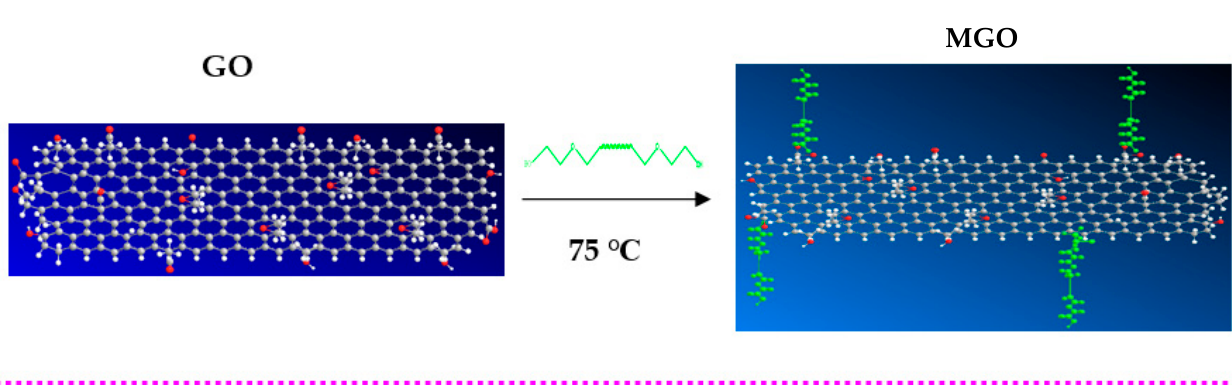
Figure 1. Preparation of polyethylene glycol grafted with graphene oxide.